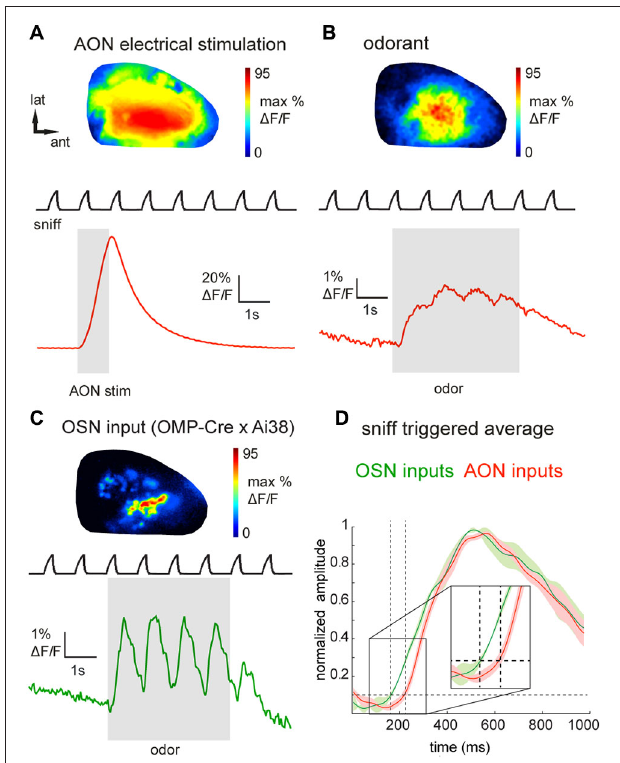
FIGURE 2 | Epifluorescence imaging of centrifugal and olfactory sensory neuron inputs to the OB in vivo using GCaMP3. (A) GCaMP3 signals imaged from the dorsal OB of an anesthetized Chrna7-Cre mouse after viral injection into ipsilateral AON. Top: Map of response to electrical stimulation of AON showing widespread fluorescence increases. Map is normalized to its own maximum. Bottom: Time-course of the optical signal. AON stimulation causes a large, transient increase in GCaMP3 fluorescence that decays rapidly. Upper trace (“sniff”) shows intranasal pressure transients during artificial inhalation. (B) Map (top) and time-course (bottom) of odorant-evoked (1% hexanal) GCaMP3 signals, displayed as in (A) . Odorant presentation evokes large fluorescence changes that are driven by inhalation and broadly distributed across the dorsal OB. (C) Map (top) and time-course (bottom) of odorant-evoked (1% ethyl butyrate) GCaMP3 signals imaged from OSN axonal terminals in an anesthetized OMP-Cre:Ai38 mouse. Signals appear as discrete, glomerular foci and display strongly-modulated inhalation-linked response dynamics. (D) “Sniff-triggered” average GCaMP3 signals comparing responses from OMP-Cre:Ai38 animals (green trace) to Chrna7-Cre animals expressing GCaMP3 in the AON (red trace). Both traces are normalized to their own maxima. Traces show mean ± SEM of the inhalation-aligned response. Sensory neuron signals display a faster onset (see also insert) compared to the signals imaged in the Chrna7-Cre animals.